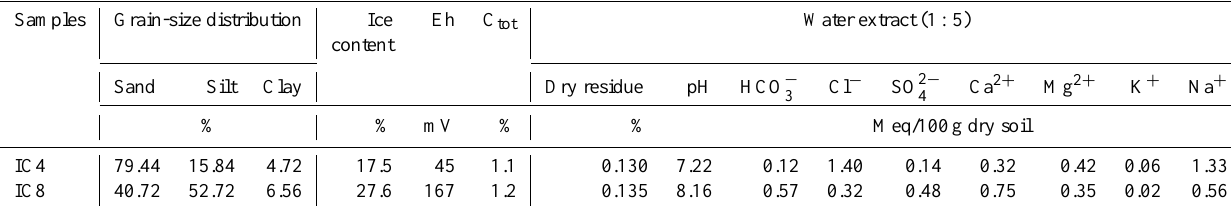
Table 1. Physicochemical characteristics of two permafrost soils. Samples Grain-size distribution Ice Water extract (1 :